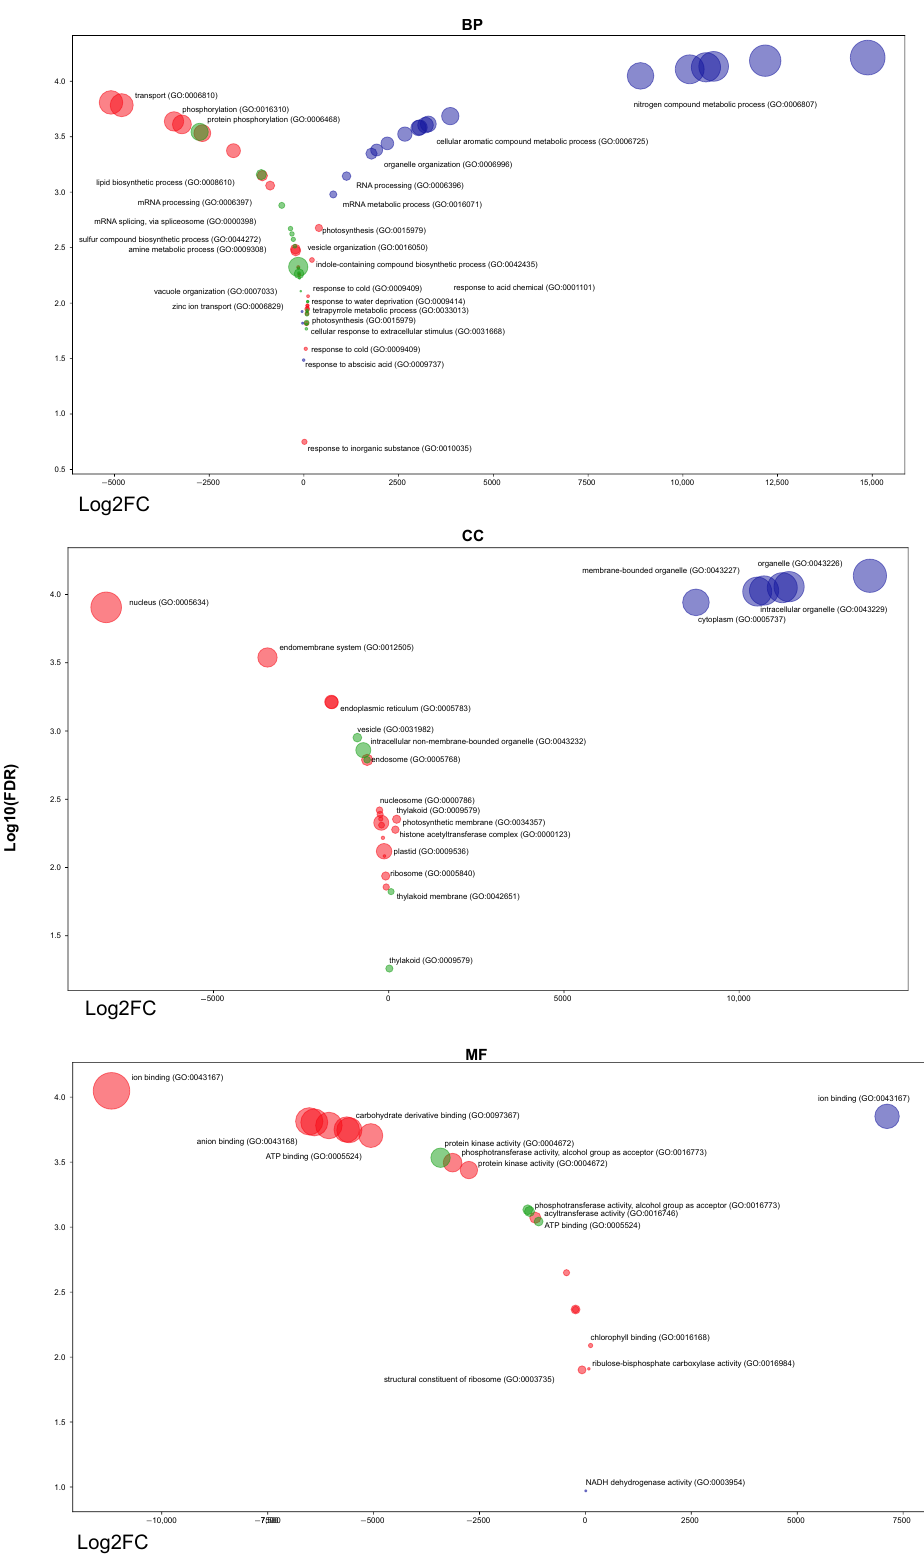
Figure 4. A bubble chart of annotated differentially expressed transcripts (DETs) and classification in the Gene Ontology (GO), with results grouped into three main categories: biological process (BP), cellular component (CC) and molecular function (MF). Bubbles were coloured (red, green and violet) according to the different genotypes (Akteur, Fengyou 3 and Svitava), respectively. Log2 FC = log2 fold of change of